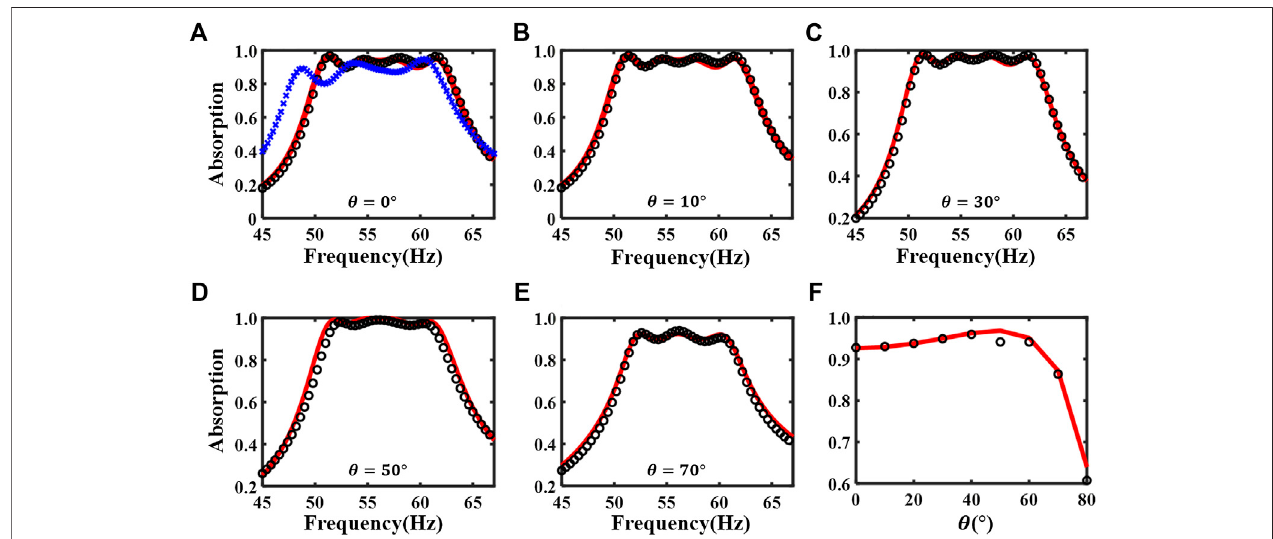
FIGURE 4 | (A) The theoretical (red solid line), the fi rst type of numerical (black circles) and experimental (blue cross) absorption coef fi cient at normal incidence for theoptimizedmetasurfaceabsorber. (B – E) Thetheoreticalandnumericalabsorptioncoef fi cientfortheanglesofincidence10 ° ,30 ° , 50 ° ,and70 ° . (F) Thetheoreticaland numerical average absorption coef fi cient over 50 – 63 Hz vs. angle of incidence.